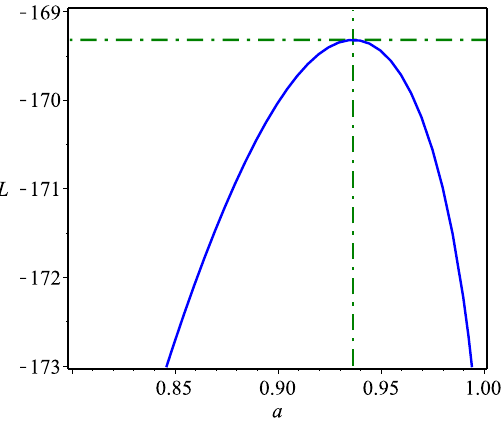
Figure 6. L profile of the DWPLT parameter based on the dataset.